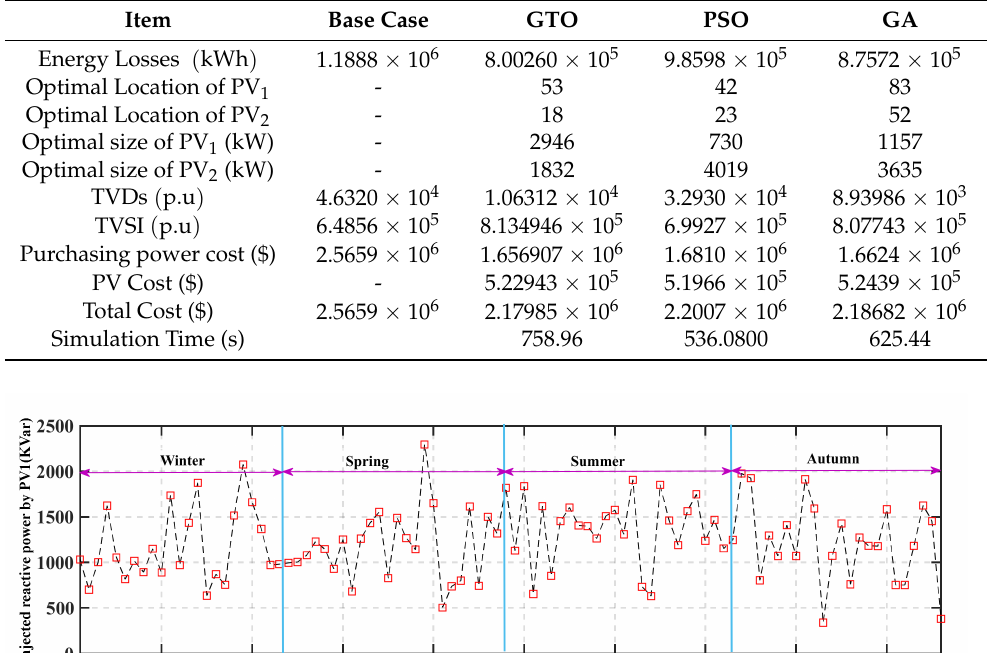
Table 3. The simulation results for case 2.